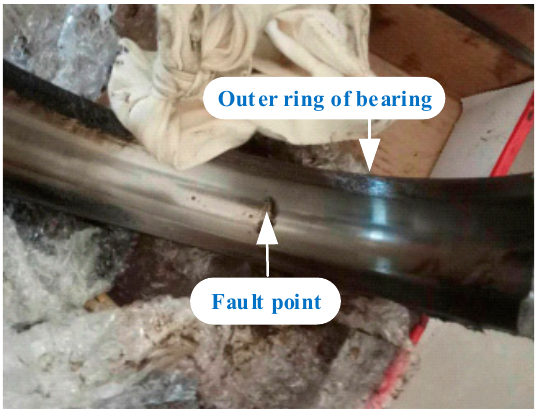
Figure 5. Vibration signals detection system of rolling bearing embedded in wind turbine generator.